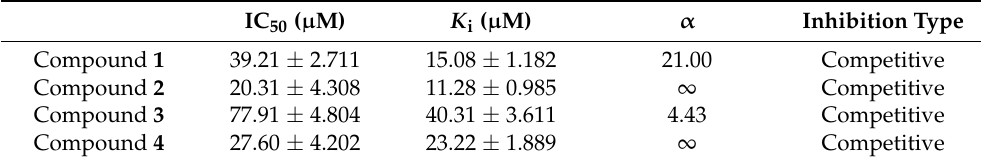
Figure 3. Inhibitory effect of increasing concentrations of the eight tested compounds on L-DOPA oxidation. Results are presented as the arithmetic mean ± standard error deviation (mean ± SEM), n = 3. Table 2. Kinetic and inhibition constants of mushroom tyrosinase obtained for (1) luteolinidin, (2) deoxymalvidin, (3) cyanidin-3- O -glucoside, and (4) malvidin-3- O